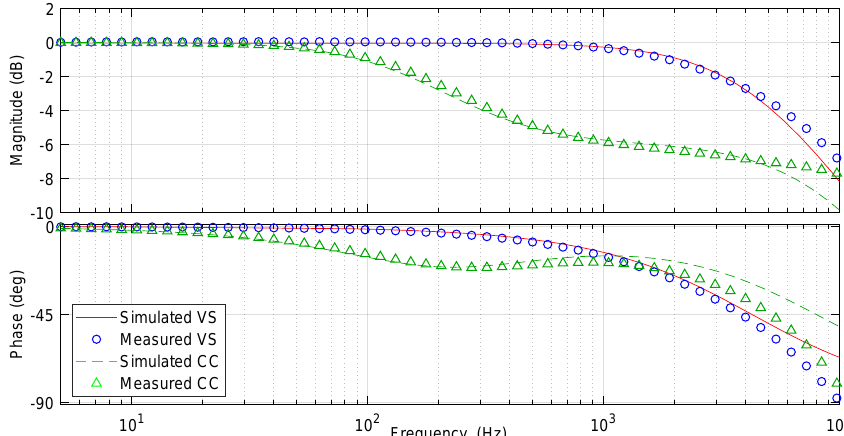
Figure 8. Amplifier Bode plots in simulation and hardware for both voltage-sourced (VS) and current-controlled (CC) inverters. In all cases, the amplifier is connected through a 150 µ H inductor to a Y-connected 4 Ω resistive load. The voltage transfer function is measured as voltage command to current response, and scaled by the resistance (4 Ω ) to produce 0 dB at low frequencies.